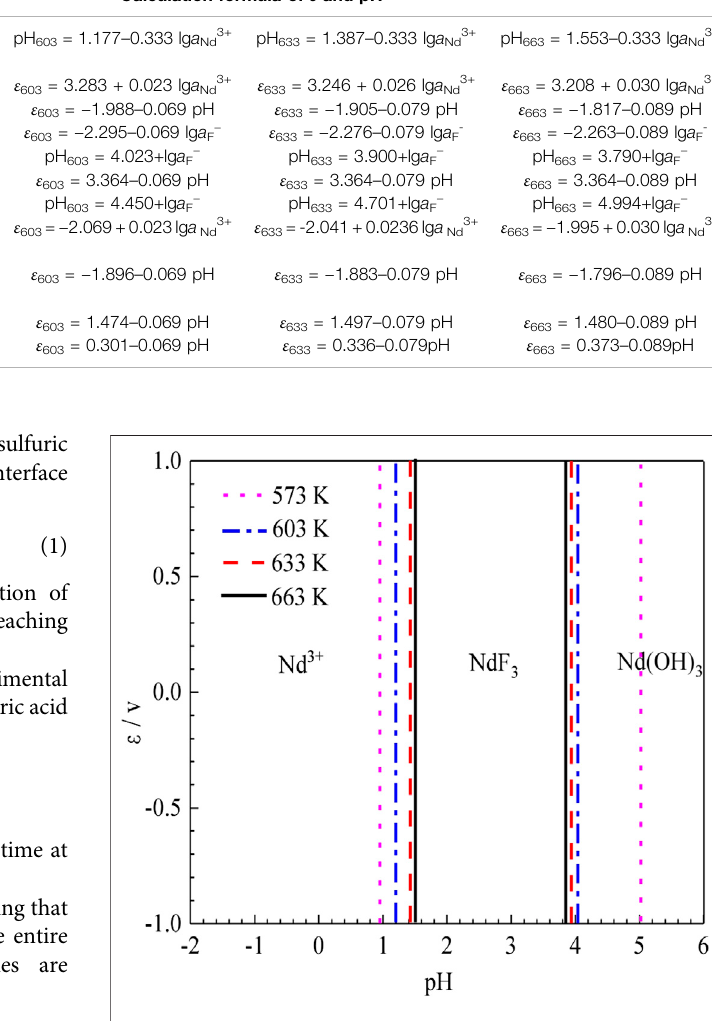
FIGURE 8 | ε -pH diagram of the Nd-F-H 2 O system with activity 1 at different temperatures.